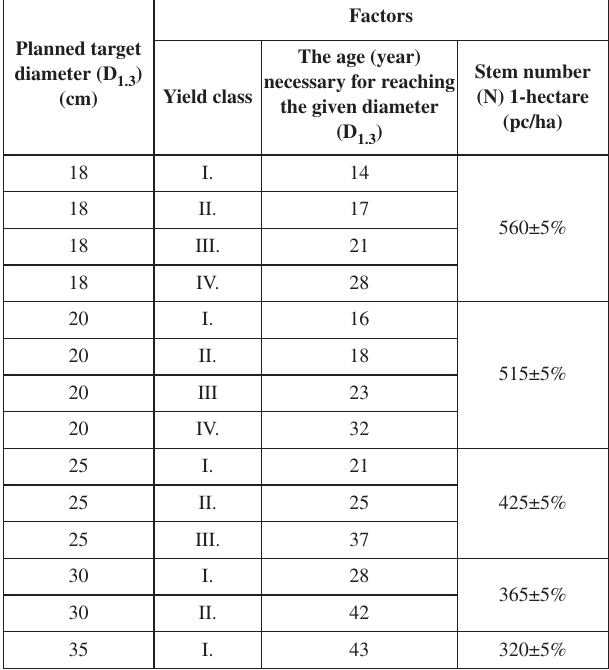
Table 2. Age-target diameter model for white poplar stand suited for quality log production